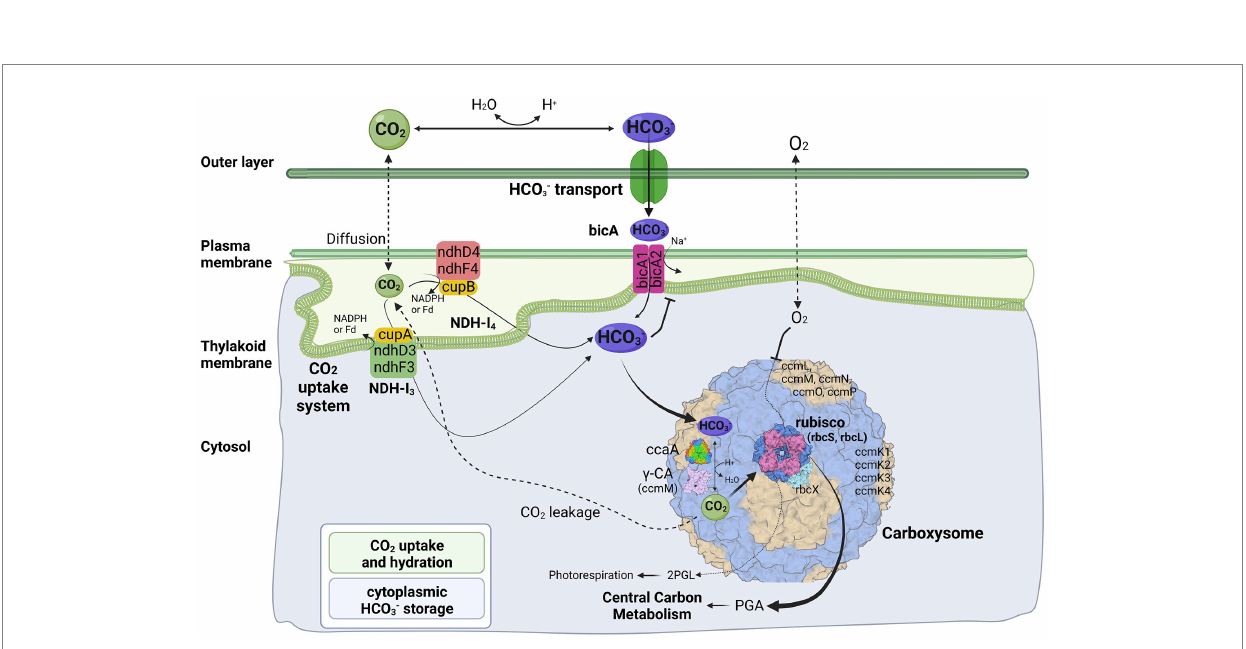
FIGURE 4 Molecular components of CCM for Trichothermofontia sichuanensis B231. 2PGL, 2-phosphoglycolate; PGA, phosphoglyceric acid. Three-dimensional structures of proteins visualized using related structures of 2YBV, 6OWF, 5SWC, 5BS1, 6KI1. Figure created with